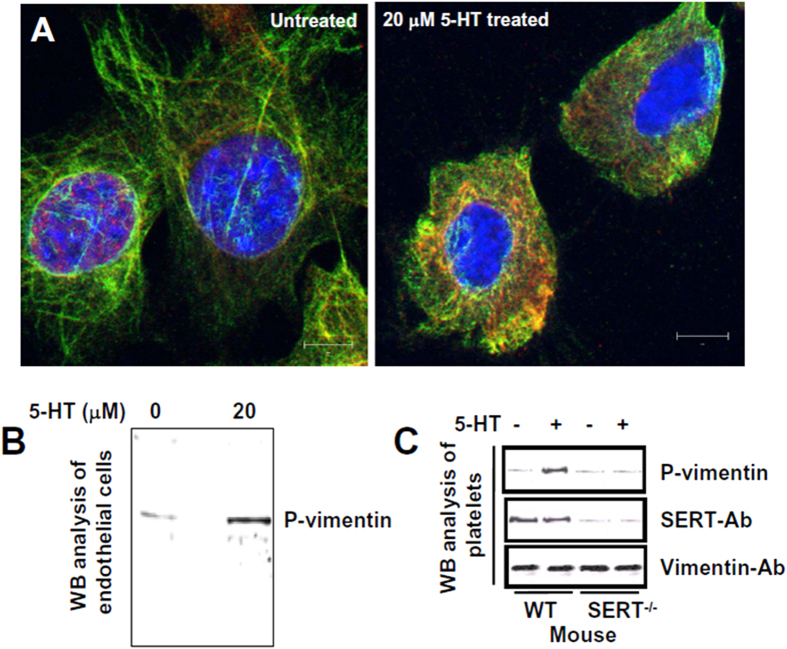
5-HT-mediated phosphorylation of vimentin.(A) IF and (B) WB analysis of endothelial cells pretreated with 5-HT. Vimentin (green) and its phosphorylated form, P-vimentin (red) were visualized by confocal microscopy in control endothelial cells and in cells pretreated with 5-HT. DNA was stainind with DAPI. Note both character an the intensity of P-vimentin staining was changed in cells pretreated with 5-HT. The bar is 10 μM. Figures show representative images from at least 2 separate experiments. WB analysis of endothelial cells confirmed IF data showing the phosphorylation of vimentin following 5-HT pretreatment. (C) 5-HT signaling and P-vimentin formation. Platelets endogenously express vimentin (lanes 1–4)) and in the 5-HT pretreatment vimentin is phopsphorylated only in the platelets of WT mice (lane 2). However platelets of SERT KO mice did not permit the phosphorylation of vimentin (lane 4). These findings indicate the involvement of 5-HT signaling in P-vimentin formation in the platelet cytoplasm.